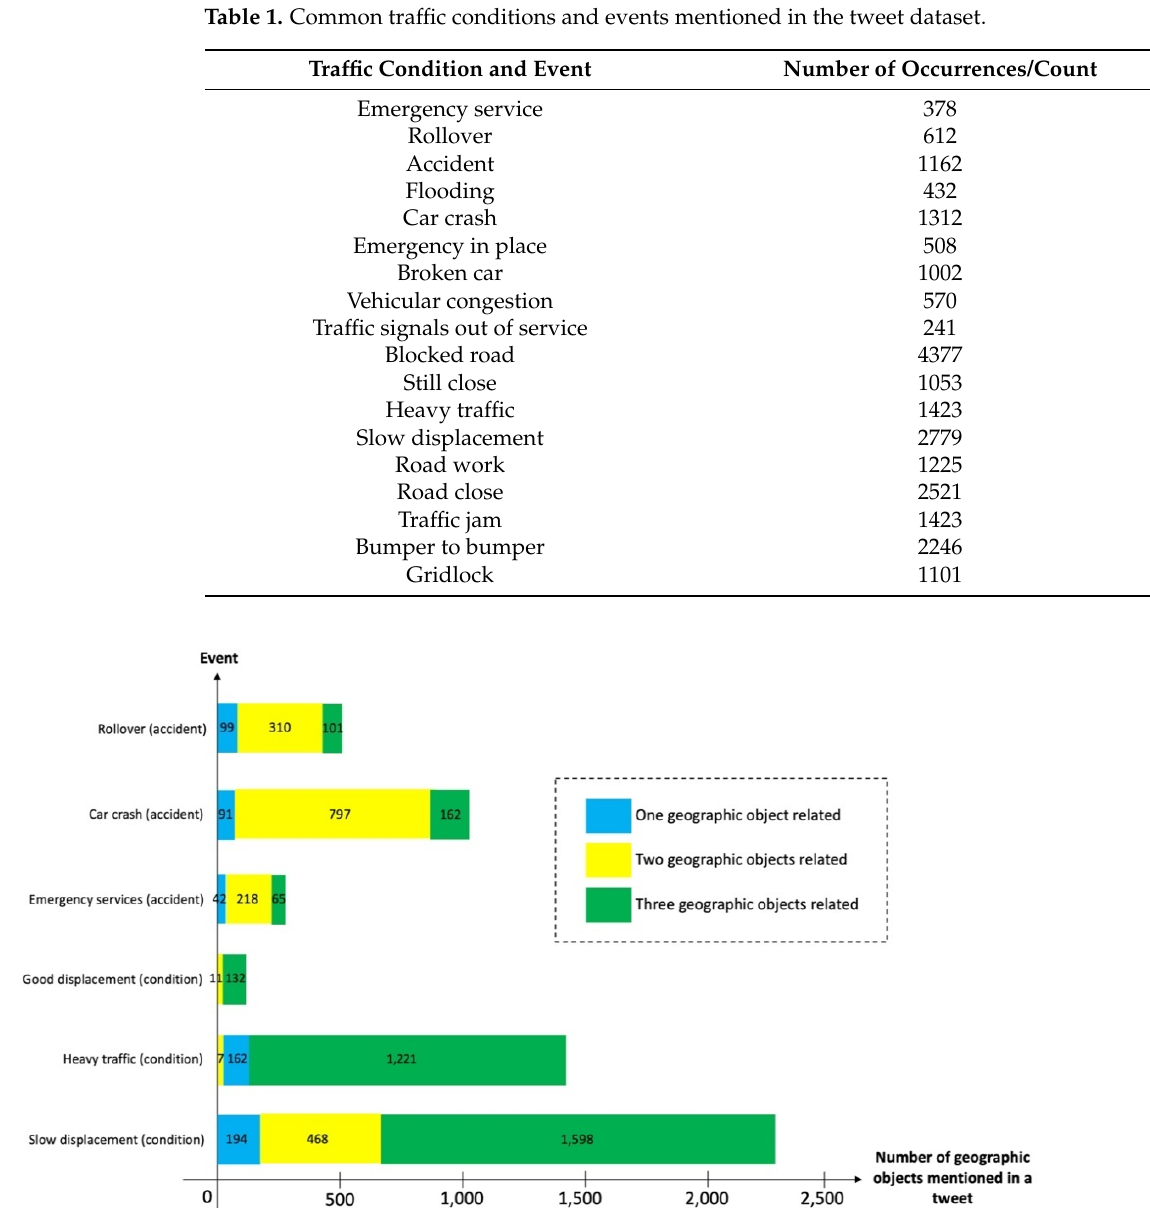
Figure 4. Examples of common traffic-related events that appear in tweets and the number of geographic elements detected with the proposed approach.